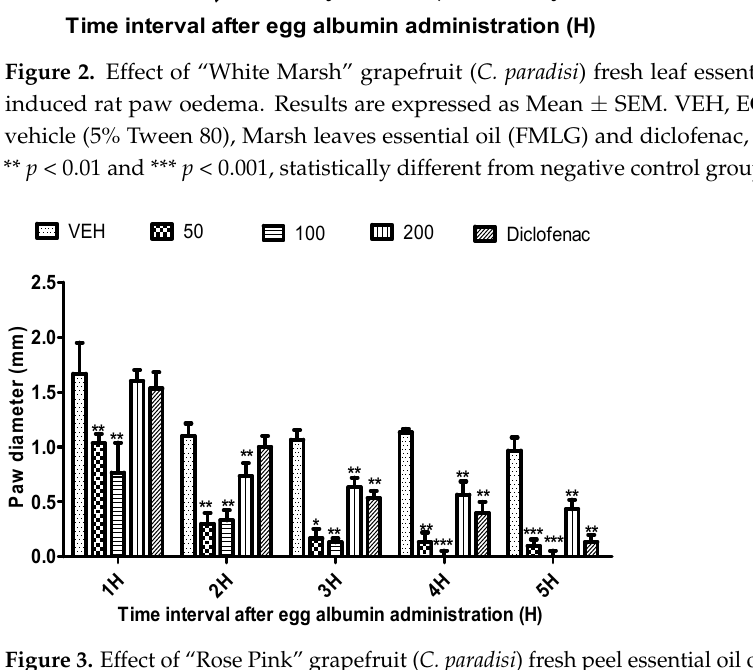
Figure 3. Effect of “Rose Pink” grapefruit ( C. paradisi ) fresh peel essential oil on egg albumin-induced rat paw oedema. Results are expressed as Mean ± SEM. VEH, ECH and ASA represent vehicle (5% Tween 80), Rose peel essential oil (FRPG) and diclofenac, respectively. * p < 0.05, ** p < 0.01 and *** p < 0.001, statistically different from negative control group (ANOVA, Dunnett’s).